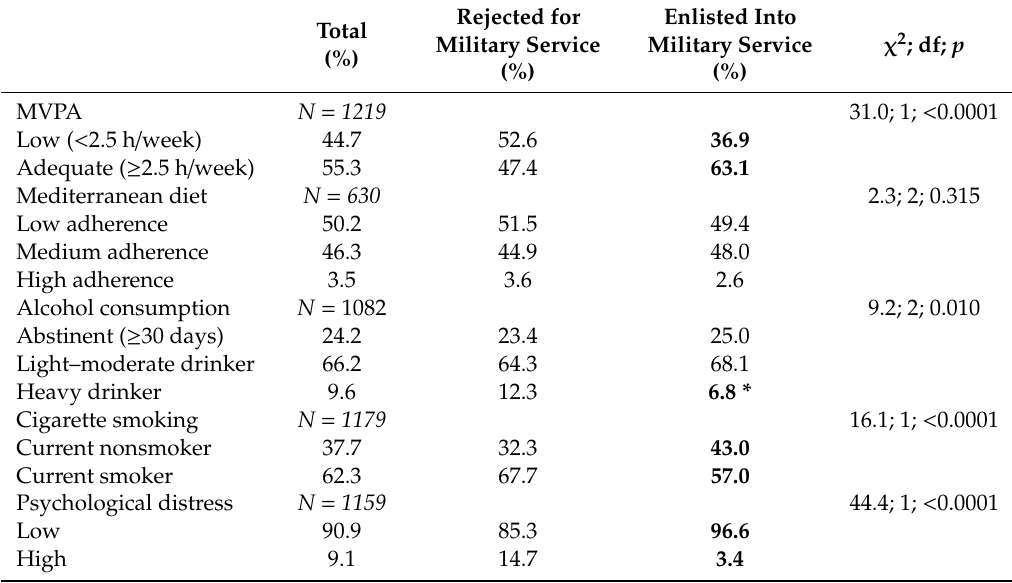
Table 1. Descriptive statistics and comparison (chi-squared test) between recruits rejected for and enlisted into military service.